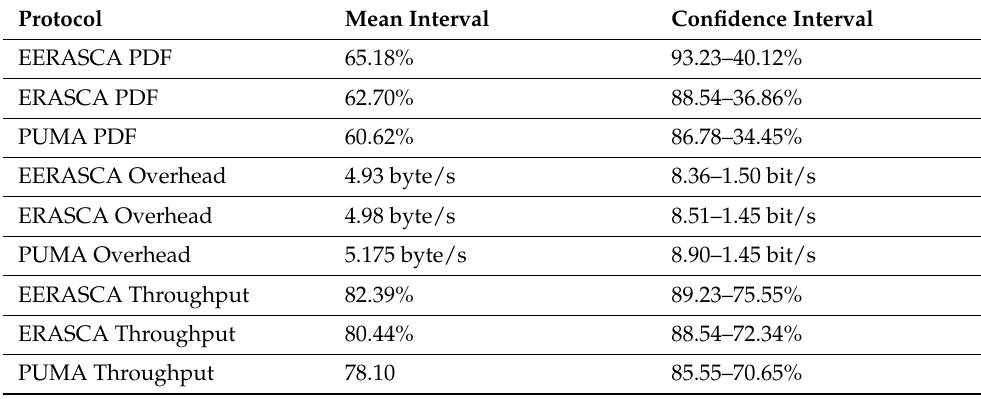
Figure 11. Comparison of Covered Area with PDF, Overhead and Throughput. Table 5. Confidence Interval for PDF, Overhead and